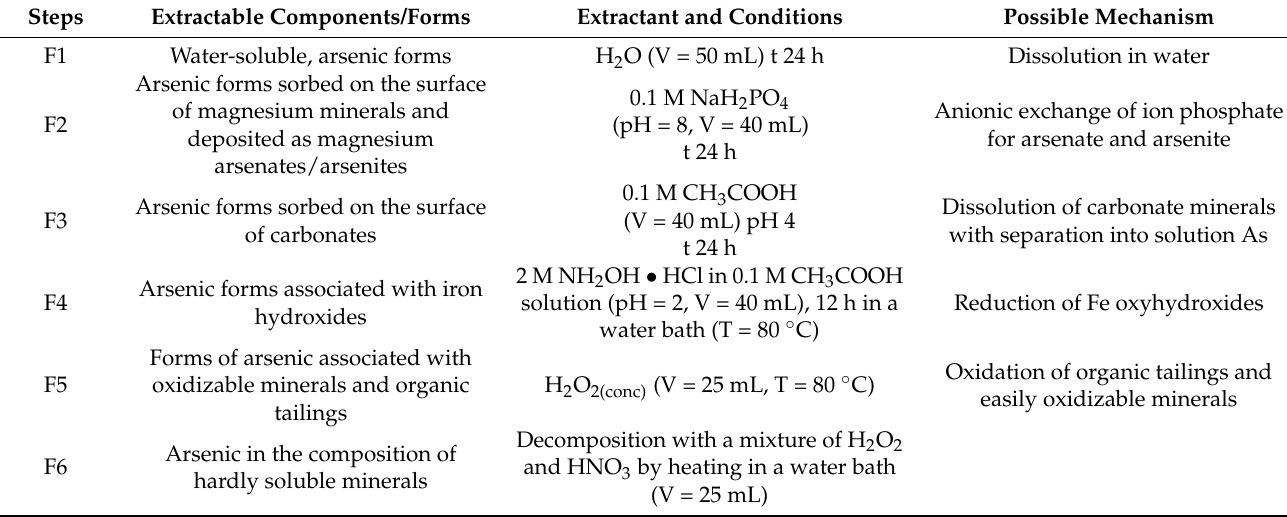
Table 1. Sequential extraction